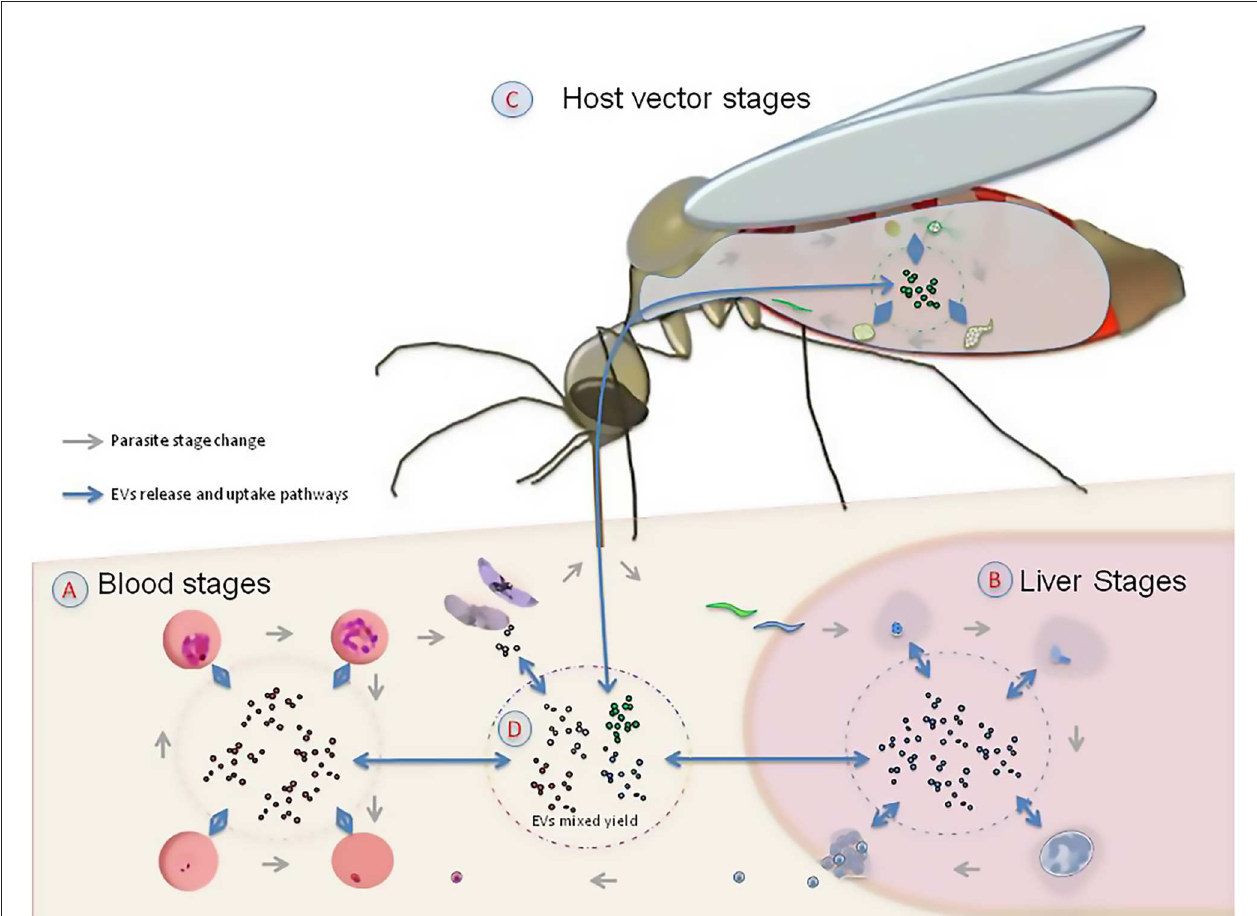
FIGURE 1 | The role of extracellular vesicles (EVs) in the life cycle of Plasmodium falciparum . Given that EVs are produced by the parasite and the hosts in the human erythrocyte (A) , the liver (B) , and the mosquito vector (C) , they are likely to play a signaling role in the interaction among host, parasite and vector (D) .